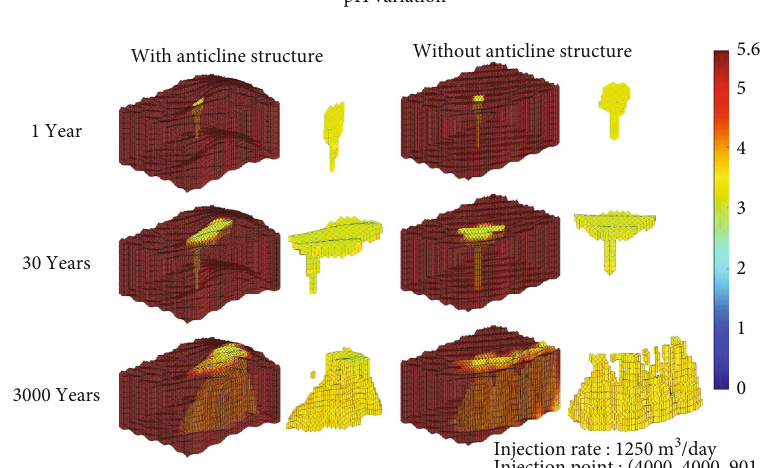
mole fraction and (b) pH variation over a geological time 2